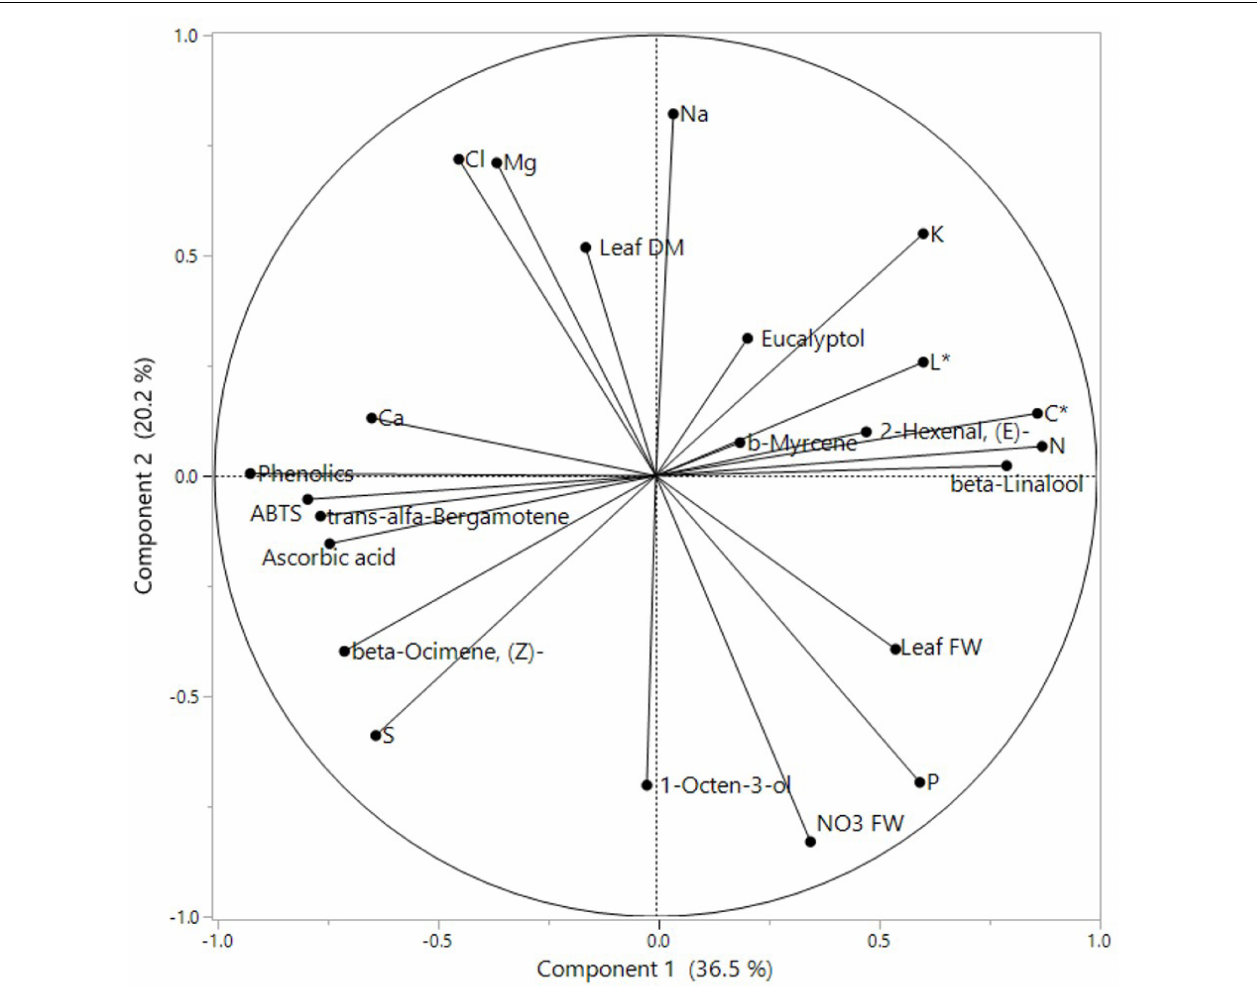
FIGURE 1 | Principal component loading plot of principal component analysis (PCA) of morphometric and yield parameters, nutritional quality, aromatic profile, leaf colorimetry, and macronutrient concentration of Green and Red cultivars grown hydroponically under iso-osmotic salinity treatments and harvested in two sequential cuts. Salinity treatments: Control = non-salt; Moderate Mix = (12.5 mM NaCl + 8.3 mM CaCl 2 ); Moderate NaCl = 25 mM NaCl; High Mix = (25 mM NaCl + 16.6 mM CaCl 2 ); High NaCl = 50 mM